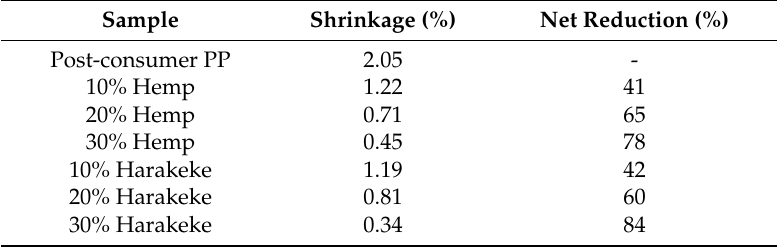
Table 4. Shrinkage results for hemp and harakeke 3D printed